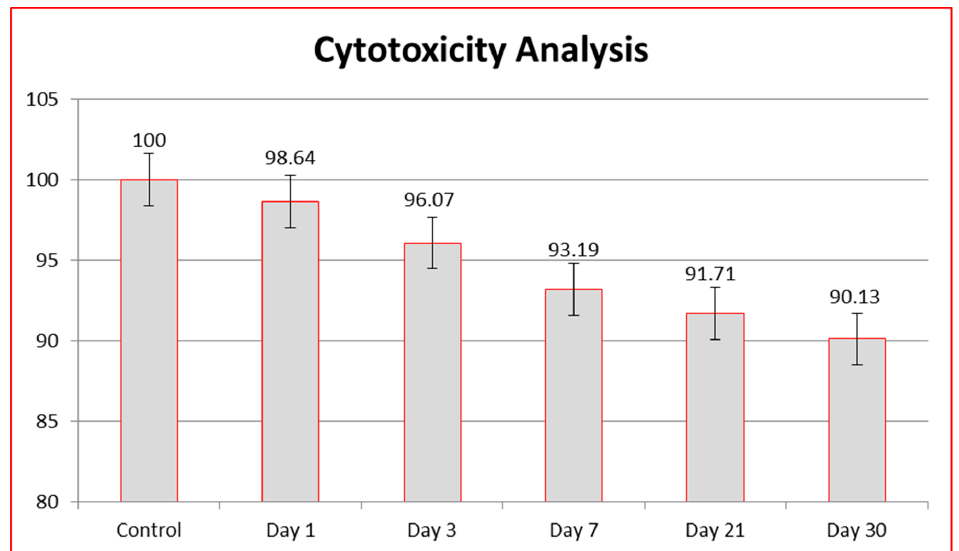
Figure 8. Cell viability (%) of TiO 2 nanoparticles at various days in comparison to the control group. Table 2. Inter-group comparison of cytotoxicity analysis of TiO 2 nanoparticles synthesized by Ba- cillus subtilis across days 1, 3, 7, 21 and 30.